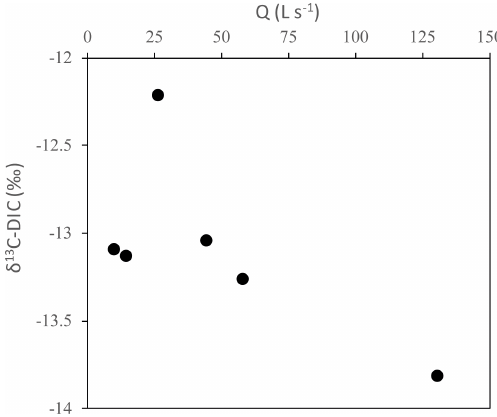
Figure 10. δ 13 C-DIC as a function of stream discharge. The six sampling occasions covered the falling limb of the snowmelt peak in April–June